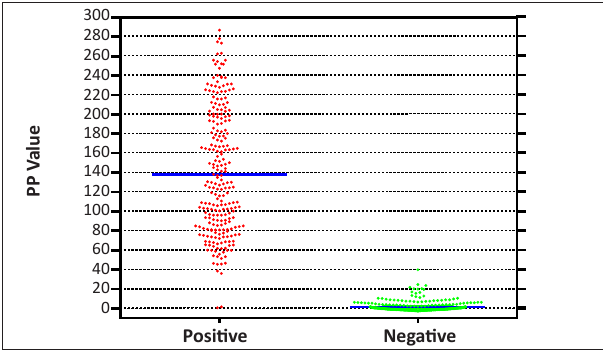
FIGURE 5: Percentage positive values for the negative ( n = 291) and positive ( n = 243) sera.